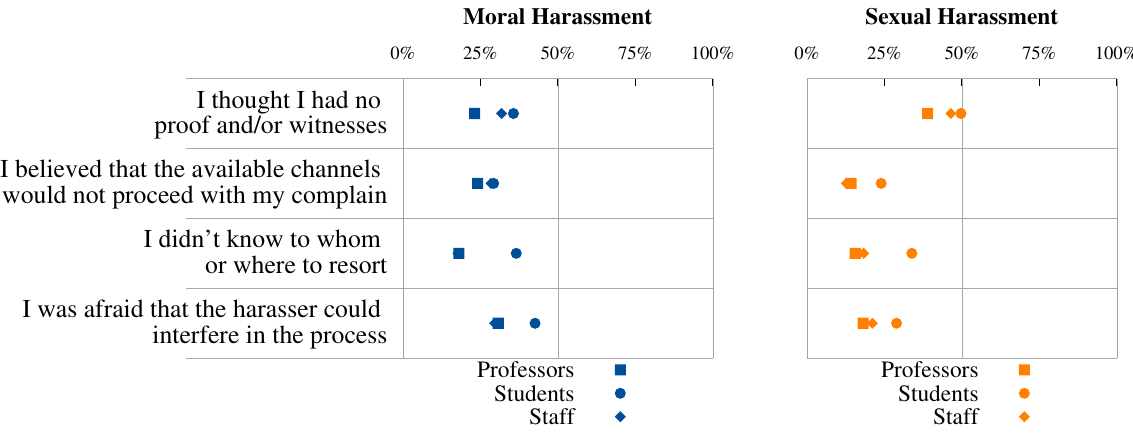
Figure 2. Reasons for not reporting moral (left) and sexual (right) harassment are listed on the left. Professors, students, and technical administrative staff are discerned through the different symbols listed in the legend.